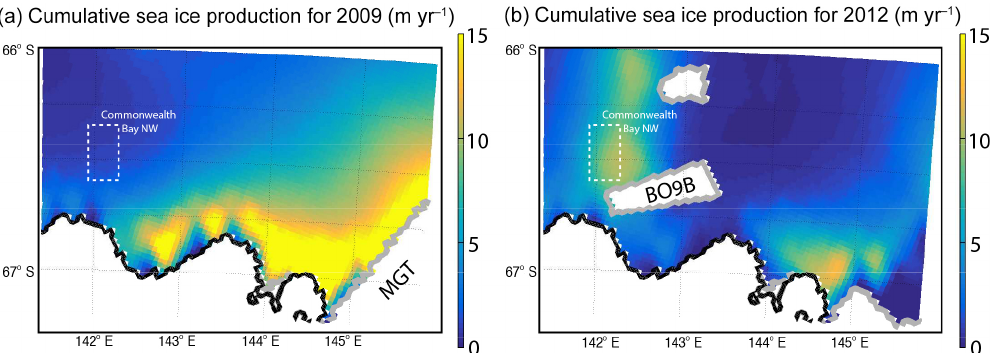
Figure 2. Cumulative sea-ice production estimated from the Special Sensor Microwave Imager (SSM/I) observations for the Mertz and Commonwealth Bay region for pre-2009 (a) and post-2012 (b) Merzt Glacier tongue (MGT) calving (after Tamura et al., 2016). The location of the Commonwealth Bay NW area is shown by a dashed white box, and B09B is outlined in light grey.